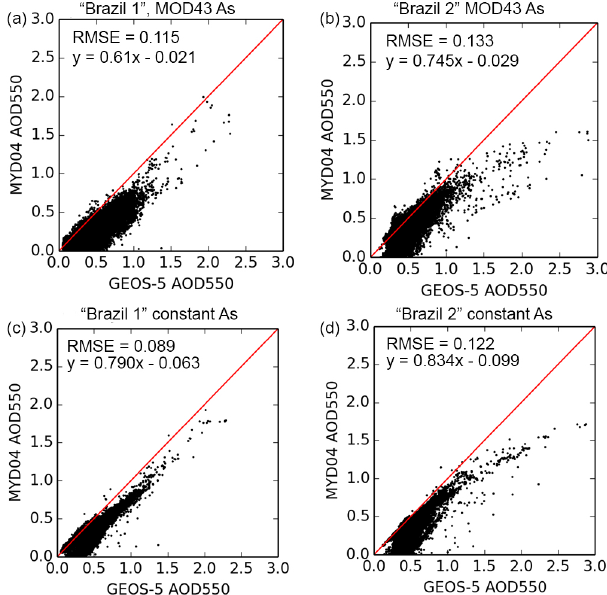
Figure 6. Surface albedo effect on Brazil smoke cases. Panels (a) and (c) show the runs with MOD43-derived surface albedo. Pan- els (b) and (d) show the effect of selection of a constant dark land surface